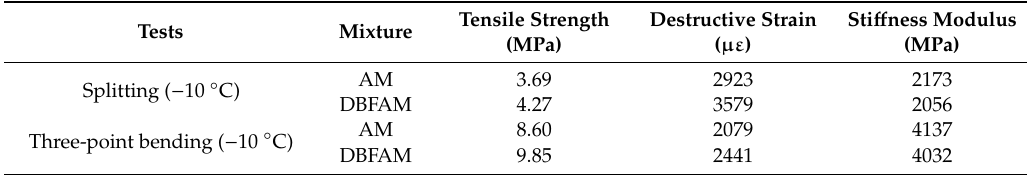
Table 12. Test results of cracking resistance at low temperature.